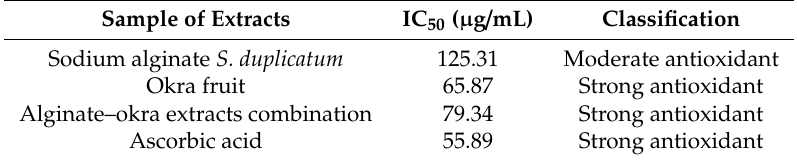
Table 1. Antioxidant activity of alginate, okra fruit and alginate–okra fruit extracts combinations (AOEs).